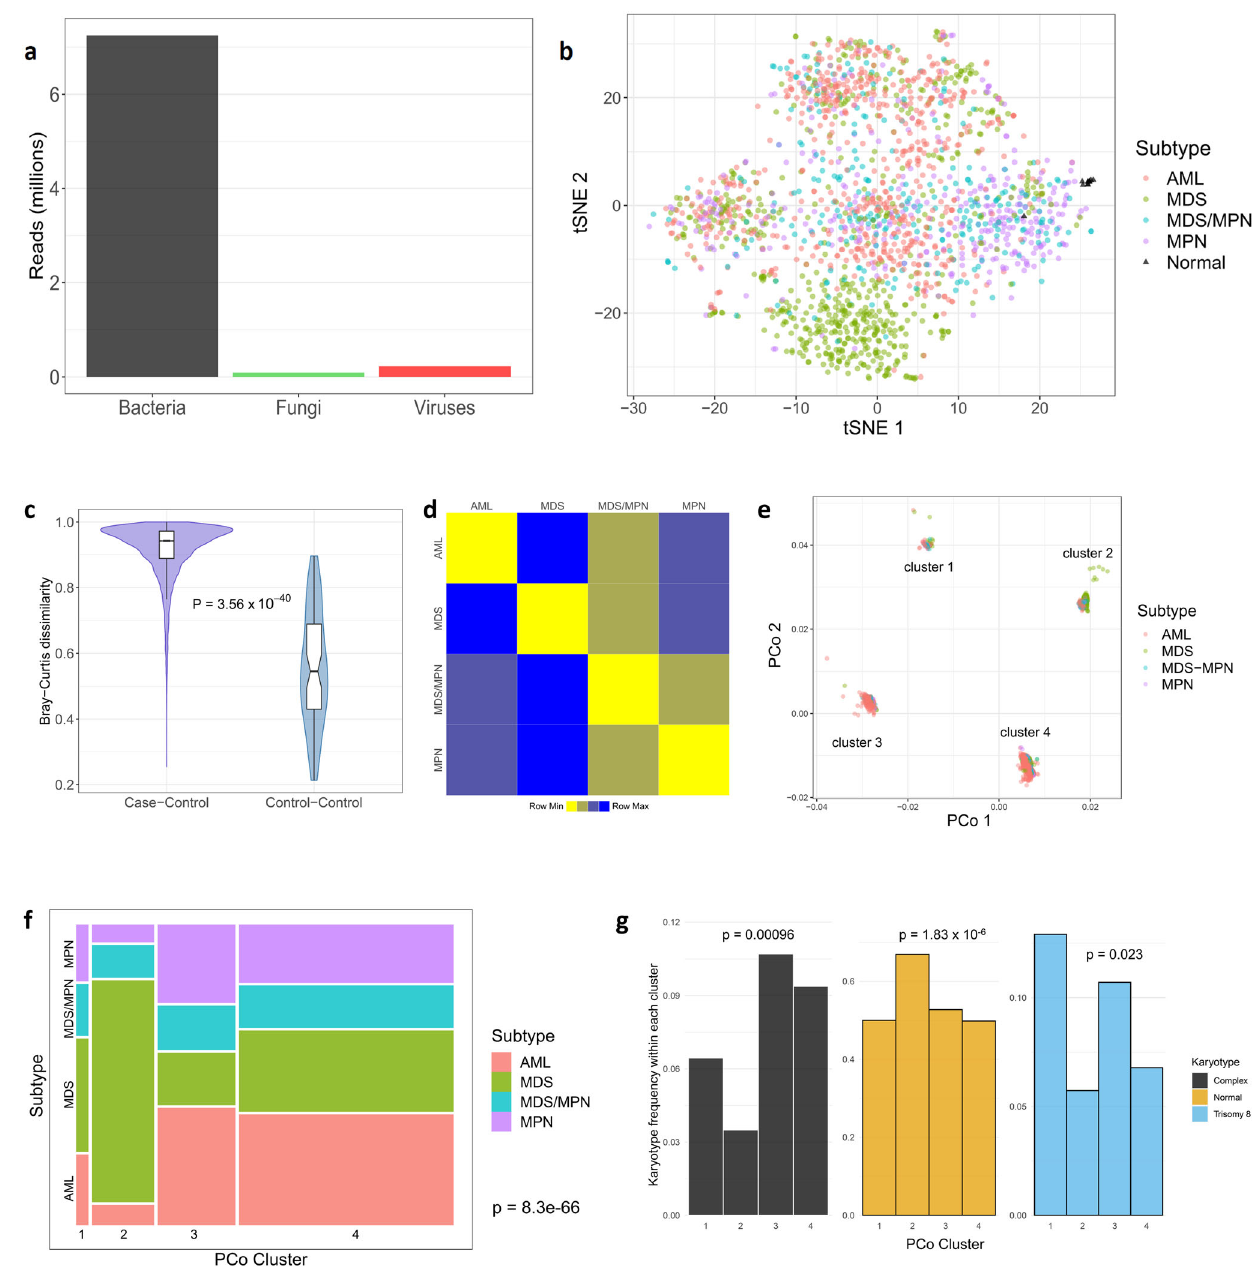
Fig. 1 Landscape of microbial content in circulation. a Barplot showing total numbers of reads for each of the three kingdoms. b t-SNE plot colored by case/control status (controls shown as black triangles) and disease subtype. c Bray – Curtis dissimilarity measures, on the genus level, based for all case- control pairs (left, n = 22,440 comparisons) and all pairs of control samples (right, n = 66 comparisons). In boxplots, bounds of box indicate fi rst and third quartiles, center line indicates median, and whiskers extend to ( fi rst quartile − 1.5 × IQR) and (third quartile + 1.5 × IQR) or extrema, whichever is less extreme (here IQR = interquartile range, i.e. third quartile − fi rst quartile). P -value computed using two-sided Wilcoxon test. d Heatmap representing the average of all Bray – Curtis dissimilarity measures between sample pairs from the indicated groups. Squares are colored according to rank in the row (yellow = most similar, blue = least similar). e The fi rst two principal coordinates, on the genus level, colored by disease subtype as in panel ( b ). For clarity, two outliers (an MDS patient and an AML patient) are omitted. f Mosaic plot indicating the proportion of the patient cohort in each cluster/subtype pair. The area of each rectangle (colored by subtype) is proportional to the number of patients in the corresponding subtype and cluster. P -value from chi- squared test. g Barplots indicating proportion of patients, within each principal coordinate cluster, with complex karyotype, normal karyotype, and trisomy 8. P -values from two-sided logistic regression-based test. tSNE t-distributed stochastic neighbor embedding, PCo principal lower in EBV-positive individuals (Wilcoxon P = 0.033). This overall lack of association suggests that EBV presence is a risk factor that is independent of IPSS-R, which is unsurprising given our observation that EBV re fi nes IPSS-R ’ s low-risk prognosis.